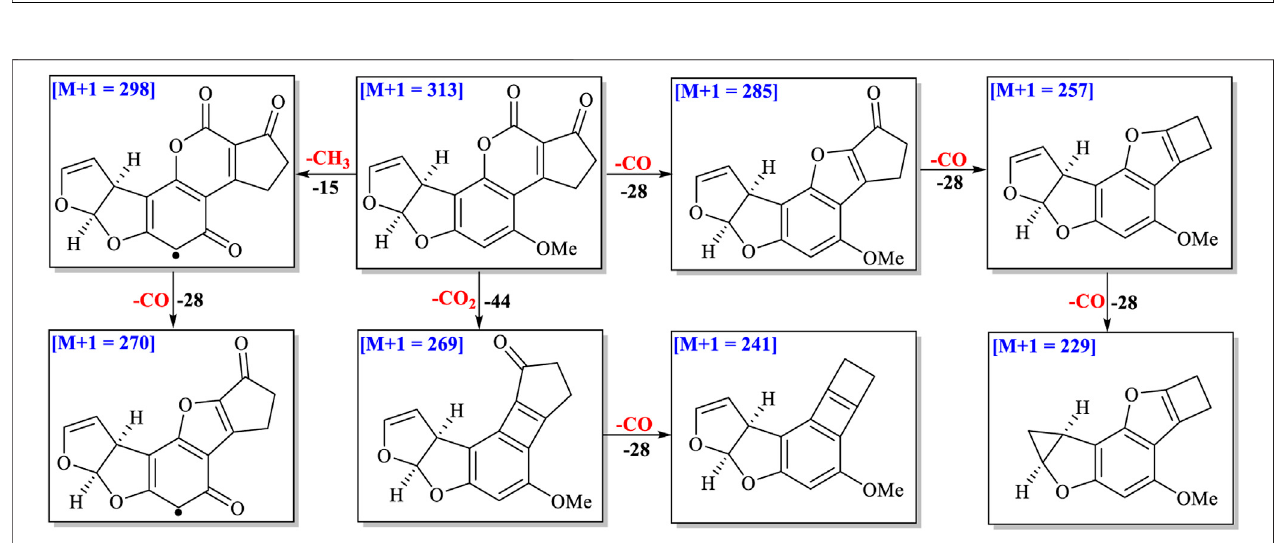
FIGURE 2 | UPLC-Q-TOF-MS/MS pro fi les of the degradation products of a fl atoxin B 1 in acetone solvent. (A) Base peak intensity (BPI) of a fl atoxin B 1 . (B) Base peak intensity (BPI) of degradation products of a fl atoxin B 1 .